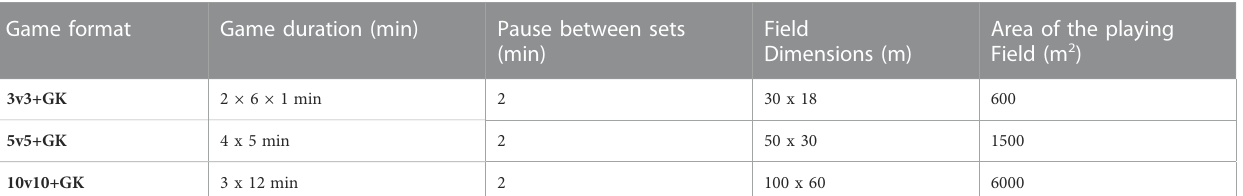
TABLE 1 Small sided games and large sided games.